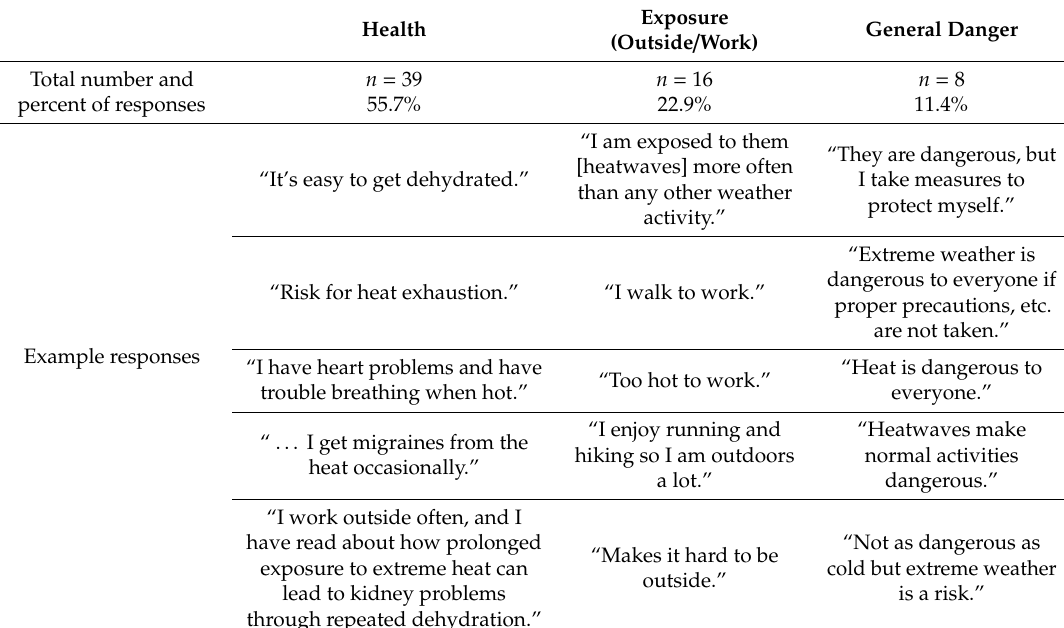
Table 3. Examples of open-ended responses to the survey question, “Why do you feel hot days and heatwaves are dangerous to you?” ( n = 70). Themes that included less than 10% of responses are not included here. Health